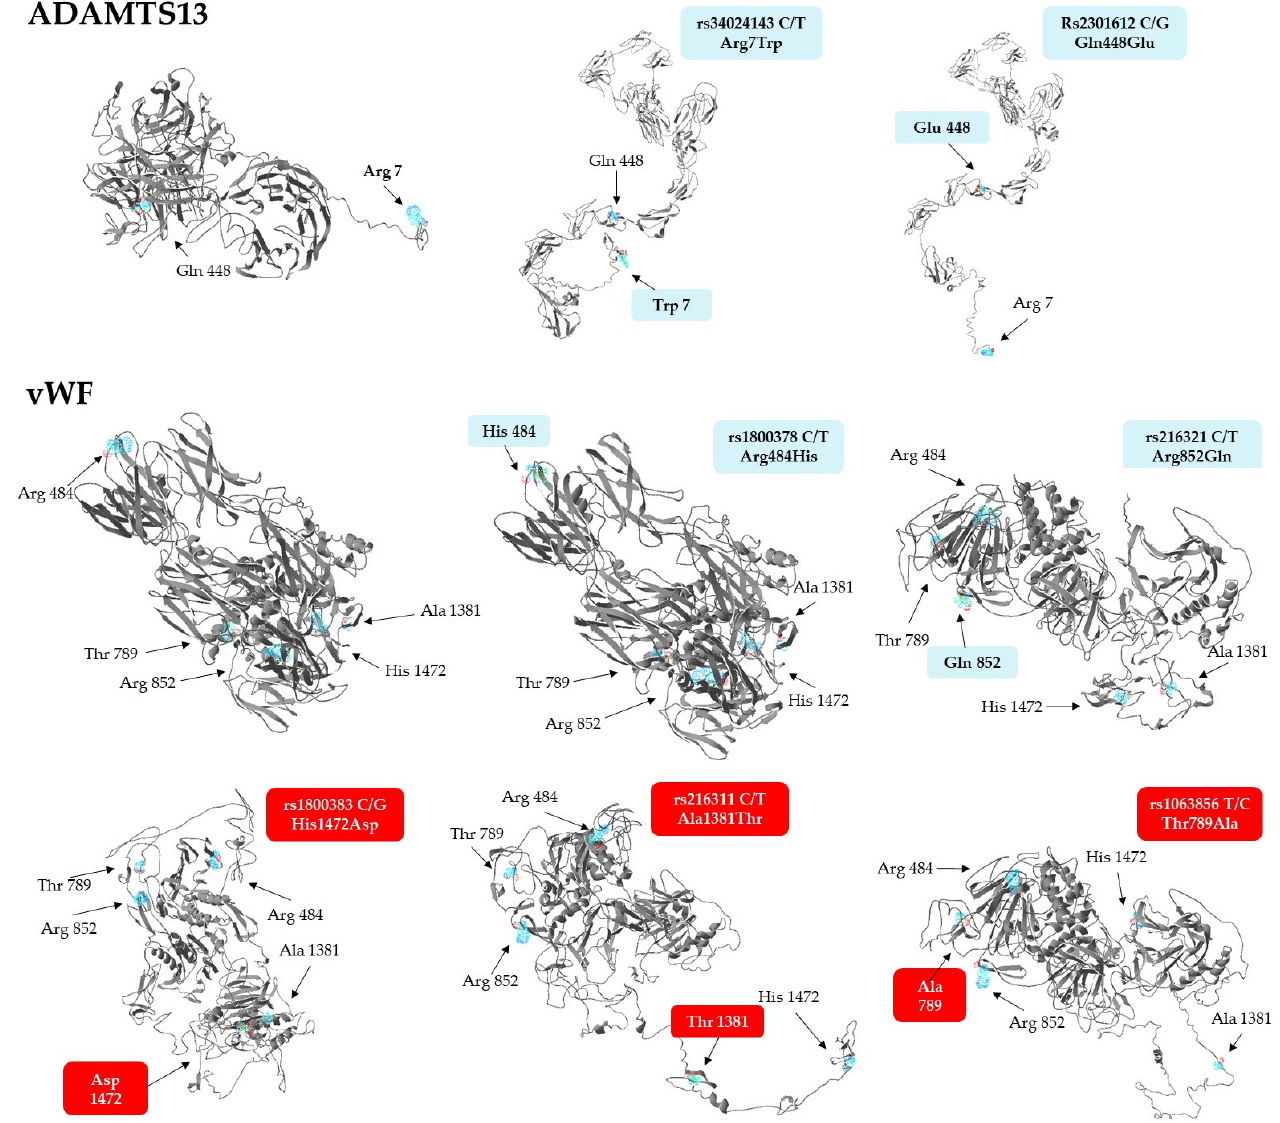
Figure 2. Steric structures of vWF and ADAMTS13 missense variants, as predicted by the I-Tasser software. Images were generated by exchanging single amino acids encoded by the minor allele of each genotyped SNP. Variants of vWF found to be associated with laboratory parameters are highlighted against a red background.